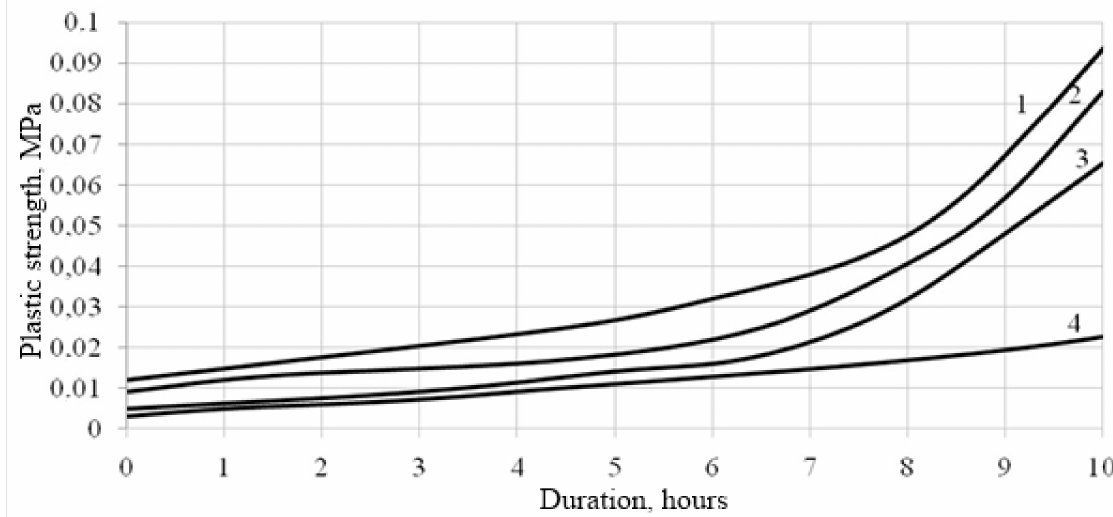
Figure 6. Change in the plastic strength of the specimen 03E depending on the filler synthesis conditions. 1—the filler was synthesized with the rapid introduction of CaCl 2 additive in an amount of 90% of the water glass mass, the specific surface of the filler is 5876 cm 2 /g; 2—the filler was synthesized with the slow introduction of CaCl 2 additive in an amount of 90% of the water glass mass, the specific surface of the filler is 4669 cm 2 /g; 3—the filler was synthesized with the rapid introduction of CaCl 2 additive in an amount of 90% of the weight of the liquid glass, and kept for three days, the specific surface of the filler is 4439 cm 2 /g; 4—lime paste (specimen